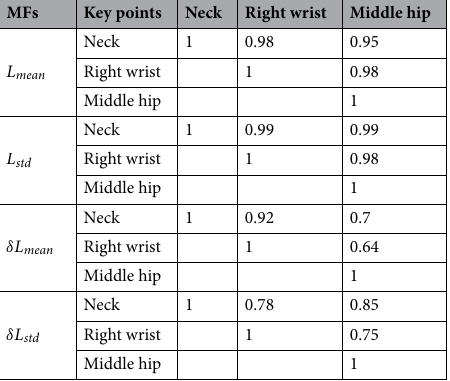
Table 3. Pearson’s correlation coefficients between the different body parts’ MFs in the Table-play